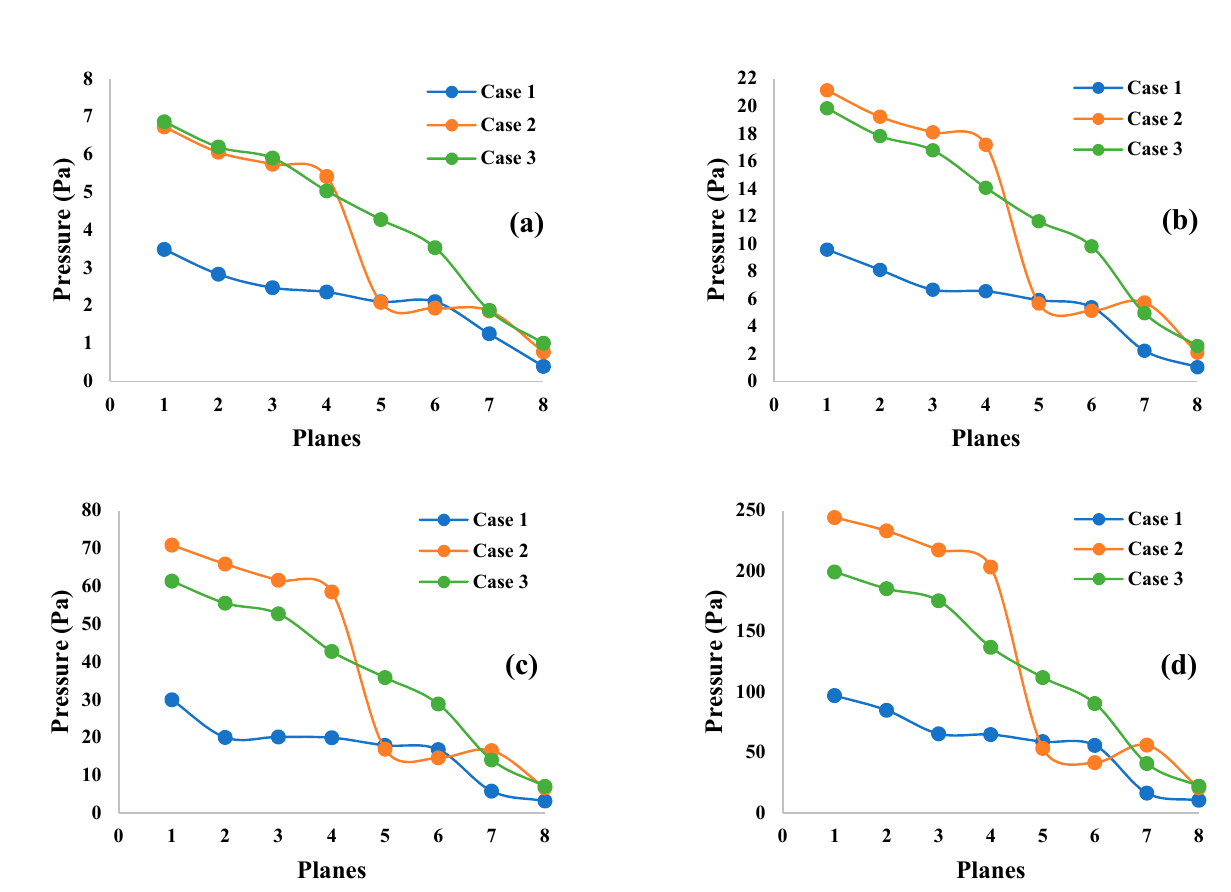
Figure 9. Pressure at selected positions of the mouth-throat and upper airways for three different lungs at ( a ) 7.5 L/min, ( b ) 15 L/min, ( c ) 30 L/min, and ( d ) 60 L/min. Case 1, 50-year-old lung; Case 2, 60-year-old lung; and Case 3, 70-year-old lung.